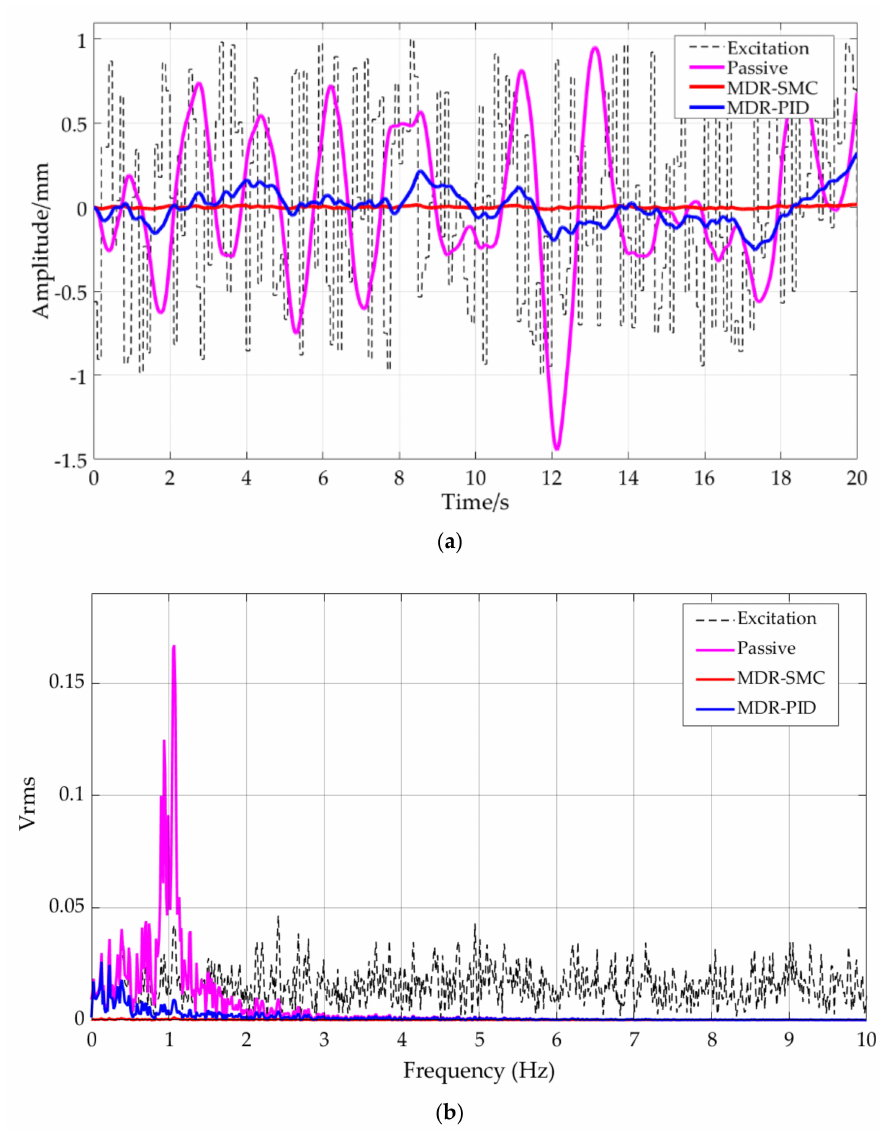
Figure 23. Comparison of the SMC with MRD, PID with MRD, and the passive system under normal distributed random signal: ( a ) the time domain curve; ( b )